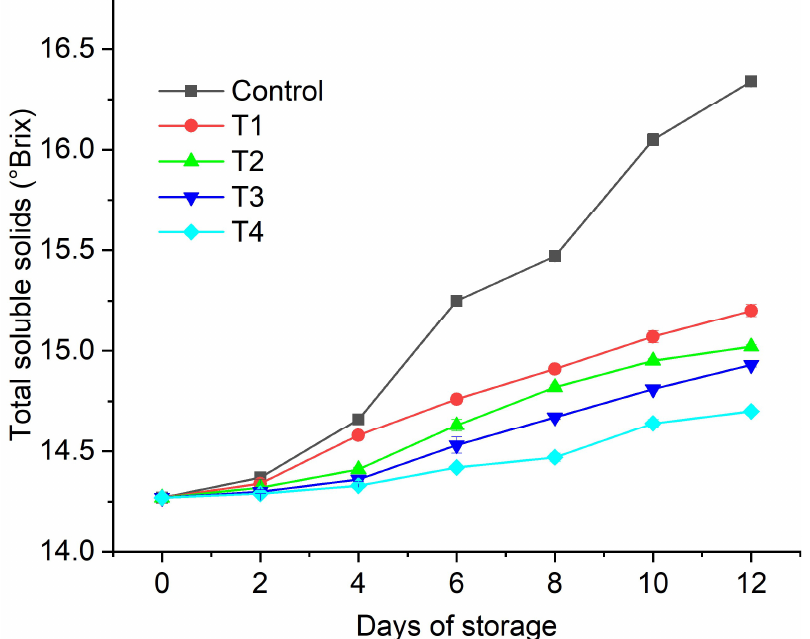
Figure 5. Effect of edible coatings on total soluble solids of Ficus carica fruits: uncoated control, AVG (T1), AVG + glycerol (T2), AVG + glycerol + anthocyanin 0.2% (T3), AVG + glycerol + anthocyanin 0.5% (T4). Data are presented as mean ± SD, ( n = 3) (error bars are significantly smaller than the data points).